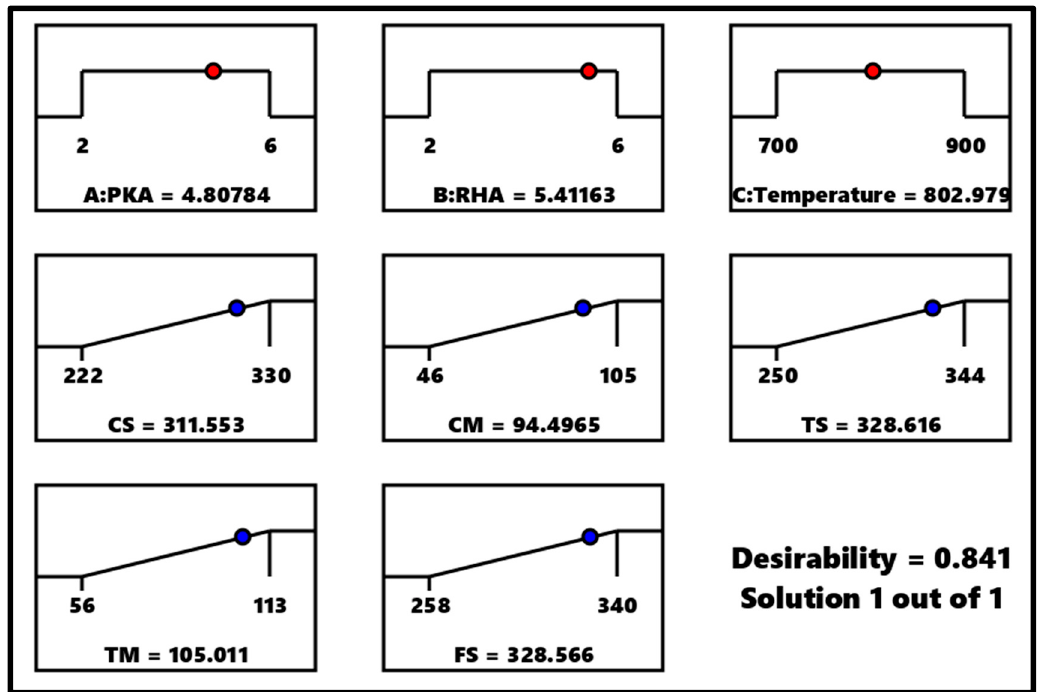
Figure 17. Optimization ramp.